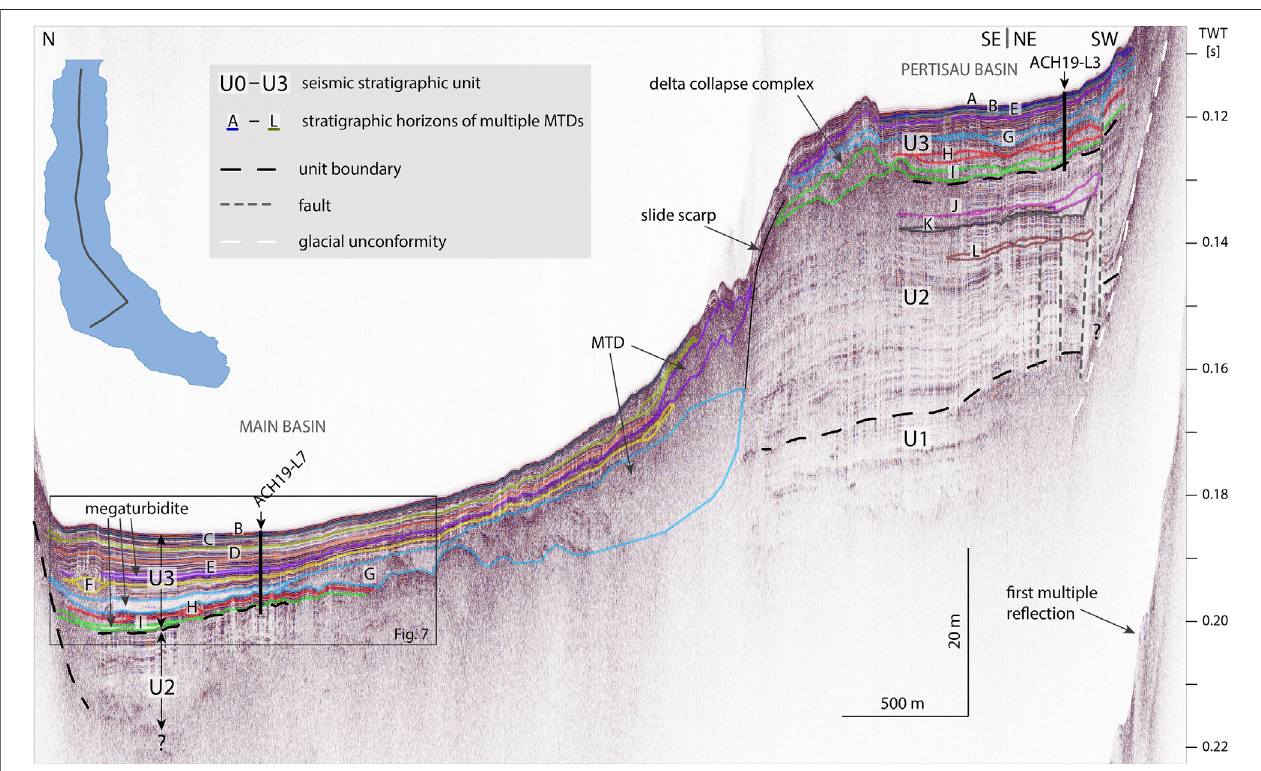
FIGURE 3 | Pinger seismic pro fi le across and along the Pertisau basin towards the long axis of the Main basin showing comparable seismic units U2 and U3 and event horizons (A – L) correlated by core-to-core-to-seismic correlation (see Core-to-Core and Core-to-Seismic Correlation ). The basins are subdivided by a slide scarp correspondingtothelarge MTDofeventG. Thedepocenter oftheMainbasin contains threemegaturbidites withinevent horizonsE,Gand I.Mapinsetshows thetrend oftheseismicpro fi le.VerticalblacklinesdisplayprojecteddepthofcoreACH19-L7andACH19-L3fromtheMainbasinandPertisaubasin,respectively( Figure9 ).